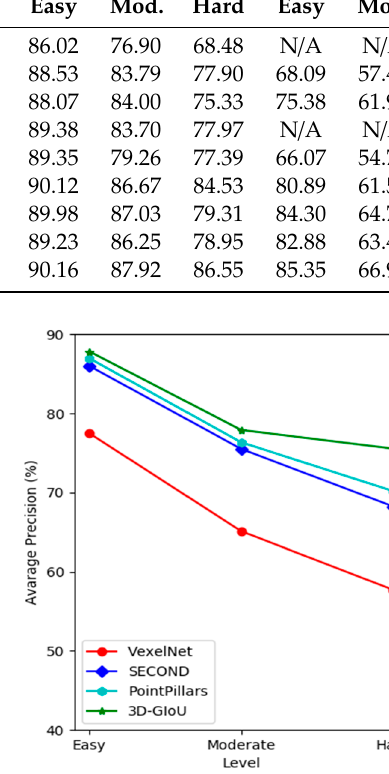
Table 2. Bird’s Eye View (BEV) detection performance: AP (%) for BEV box in the KITTI valuation set. Method